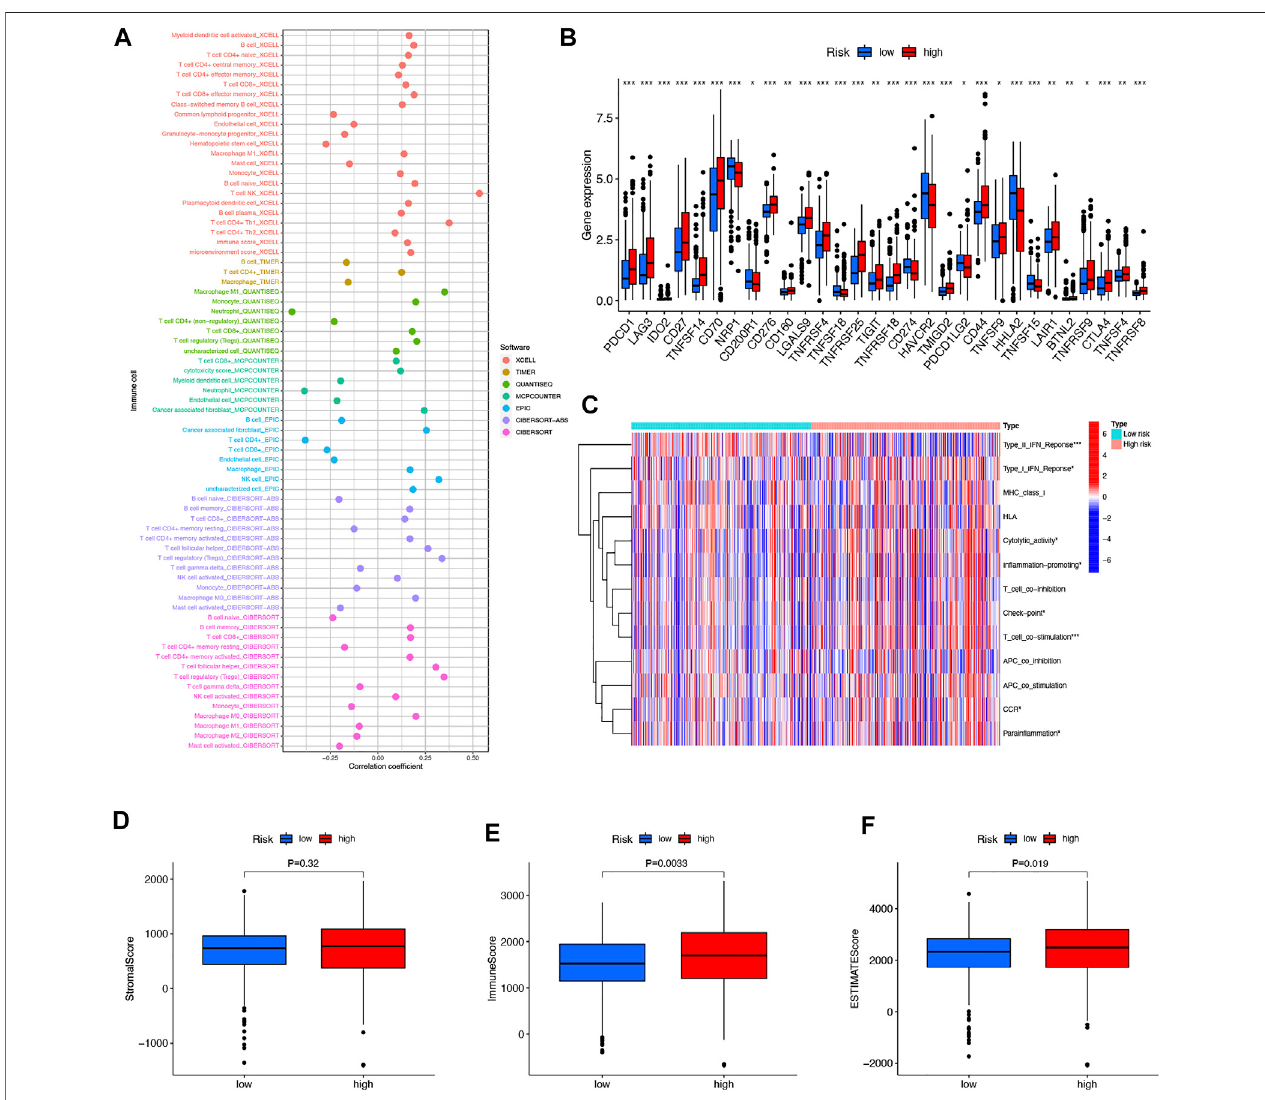
FIGURE 8 | Differences in the tumor immune microenvironment between the low- and high-risk groups. Immune cell bubble of risk groups (A) . Differences in expression of common immune checkpoints in the risk groups (B) . ssGSEA scores of immune cells and immune function in the risk group (C) . Box plots comparing StromalScore, ImmuneScore and ESTIMATEScore between the low- and high-risk groups, respectively (D – F) . * p < 0.05, ** p < 0.01, and *** p < 0.001.